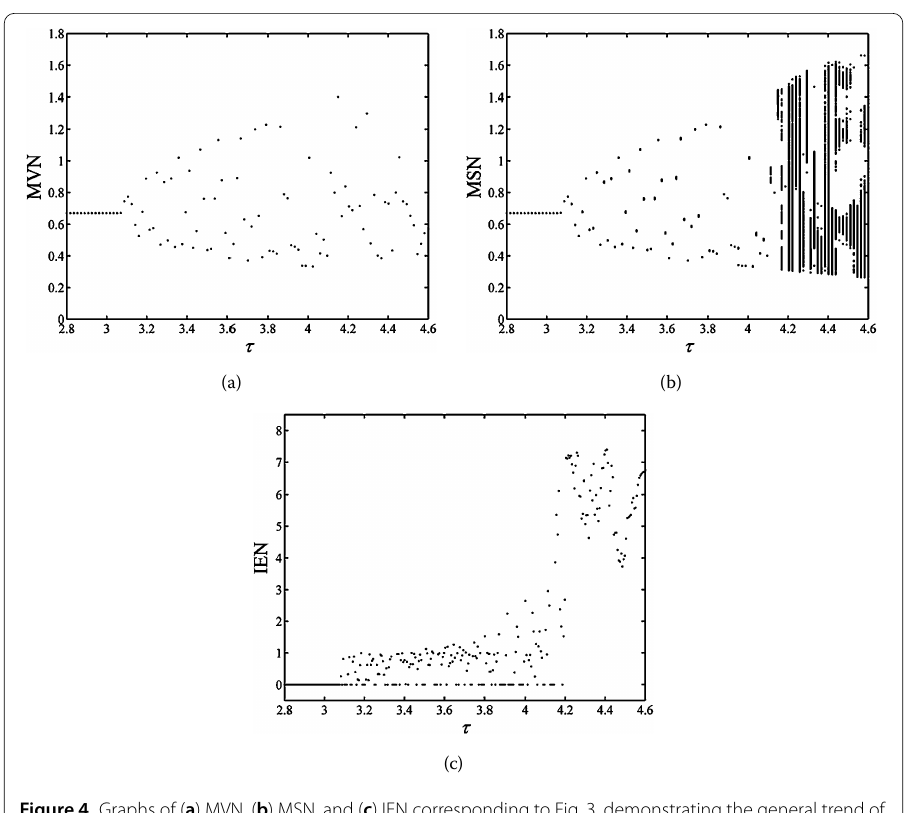
Figure 4 Graphs of ( a ) MVN, ( b ) MSN, and ( c ) IEN corresponding to Fig. 3, demonstrating the general trend of pattern transition on the route to chaos with parameter τ ranging in [2.8,4.6]